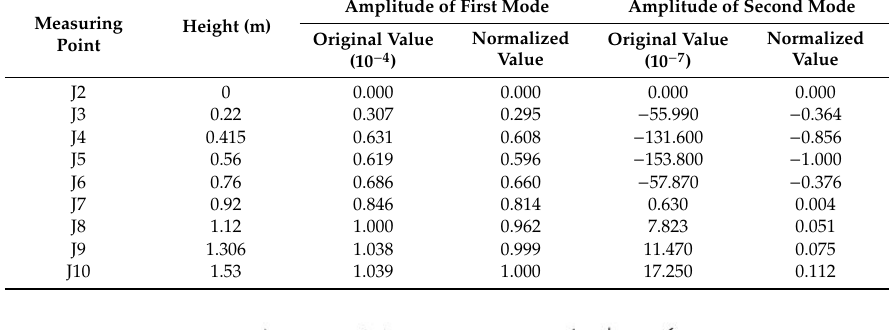
Table 7. Power spectrum peaks of the first and second mode in water condition.